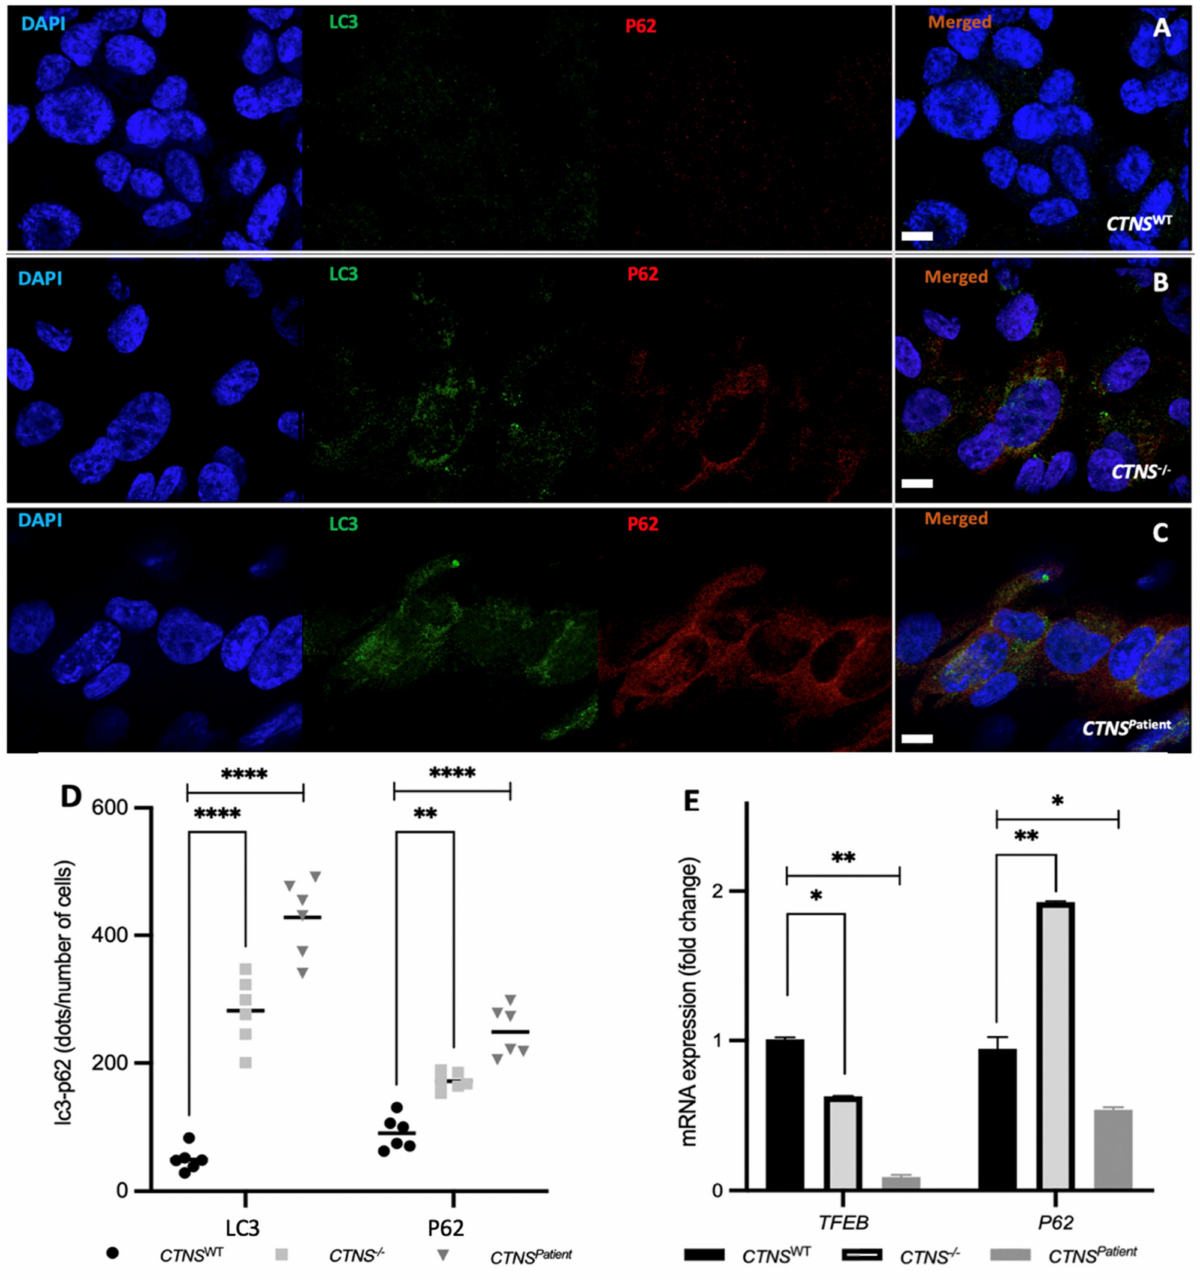
Figure 6. Autophagic markers in kidney tubules. Images obtained with a confocal microscope at 63X of the ciPTEC CTNS WT ( A ), CTNS − / − ( B ), and CTNS Patient ( C ) kidney tubules. Image quantification analysis showed a significant increase of the autophagy markers LC3 and p62 in the cystinotic 3D models when compared to the healthy control ( D ). Real-time PCR quantification also showed a significant impairment of the autophagy-related genes TFEB and p62 in the cystinotic models when compared to the healthy control ( E ). In blue: nuclei, in green: LC3 protein, in red: p62 protein. Scale bar: 10 µ m. One-way ANOVA statistical analysis was performed (N = 3; * p -value < 0.05; ** p -value < 0.01; **** p -value <